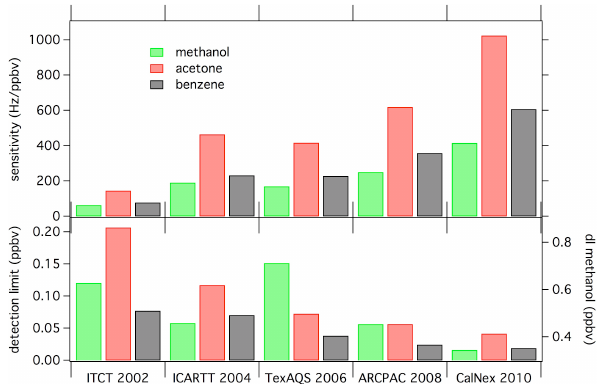
Fig. 1. The PTR-MS sensitivity and detection limits ( S/N =3) for methanol, benzene and acetone during five different aircraft mis- Figure 1: The PTR-MS sensitivity and detection limits (S/N=3) for methanol, benzene sions during the past eight years: ITCT 2002 (de Gouw et al., 2004), and acetone during five different aircraft missions during the past eight years: ITCT 2002 ICARTT 2004 (Warneke et al., 2004), TexAQS 2006 (Warneke (de Gouw et al., 2004), ICARTT 2004 (Warneke et al., 2004), TexAQS 2006 (Warneke et al., 2010a), ARCPAC 2008 (Warneke et al., 2010b) and Cal- et al., 2010a), ARCPAC 2008 (Warneke et al., 2010b) and CalNex 2010. Nex